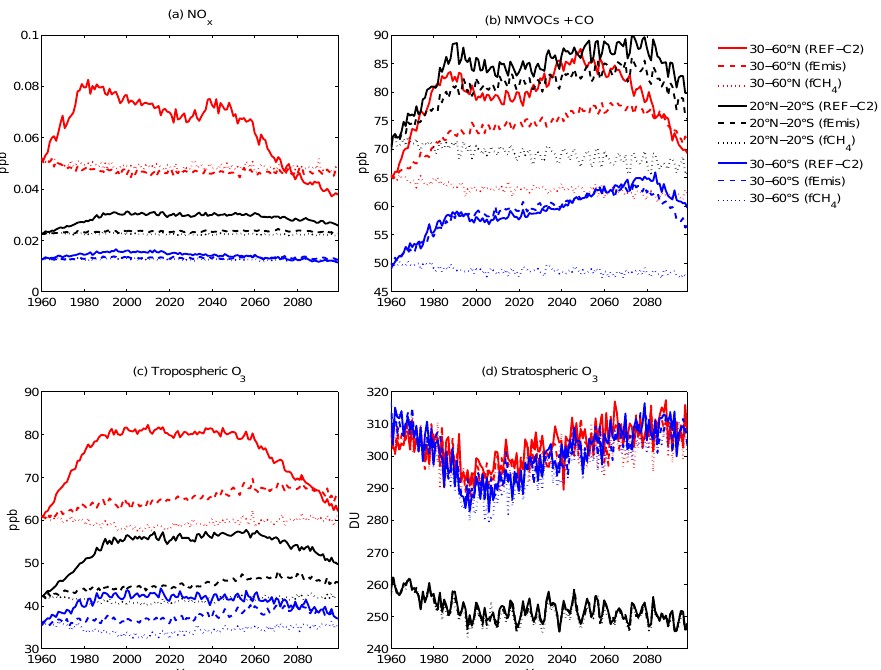
Figure 5. Time series of northern midlatitude (30–60 ◦ N, red lines), tropical (20 ◦ N–20 ◦ S, black lines) and southern midlatitude (30–60 ◦ S, blue lines): (a) NO x (500hPa); (b) NMVOCs + CO (500hPa); (c) tropospheric ozone (500hPa); (d) stratospheric column ozone. Solid lines: for the REF-C2 simulation. Dashed lines: fEmis simulation. Dotted lines: fCH 4